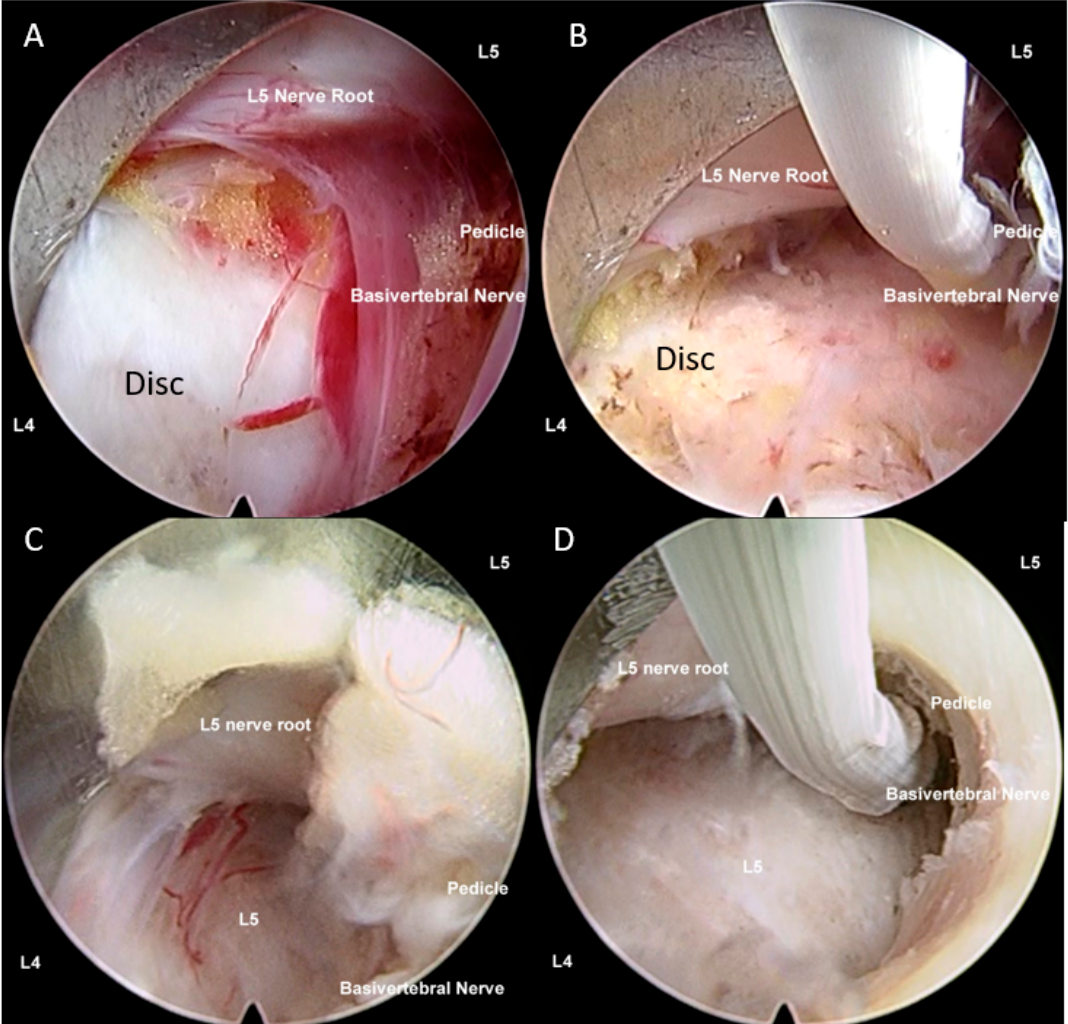
Figure 8. A: Uniportal interlaminar endoscopic approach to the disc showing the relationship of the lumbar five (L5) traversing nerve root, which is retracted away by the working channel, exposing the disc of L4/5, the basivertebral nerve is located above the pedicle of left L5, and there is grade 3 neovascularization and inflammatory granulation tissue with adhesion around the basivertebral nerve region. In most circumstances, the basivertebral nerve is too fine to be seen by endoscopic vision. B : The same region in the same patient after radio frequency was applied to shrink the degenerative disc, and to ablate the pathological neovascularization with underlying inflammatory tissues and the basivertebral nerve. The typical response is twitching of the buttock when the correct location of the basivertebral nerve is ablated. C: Another patient with similar steps in retraction of the traversing nerve root and exposing neovascularized tissue and the location of the basivertebral nerve. D : Radiofrequency ablation applied to neovascularized tissue, disc, and basivertebral nerve (figure reproduced with permission from Kim et al. [12]).